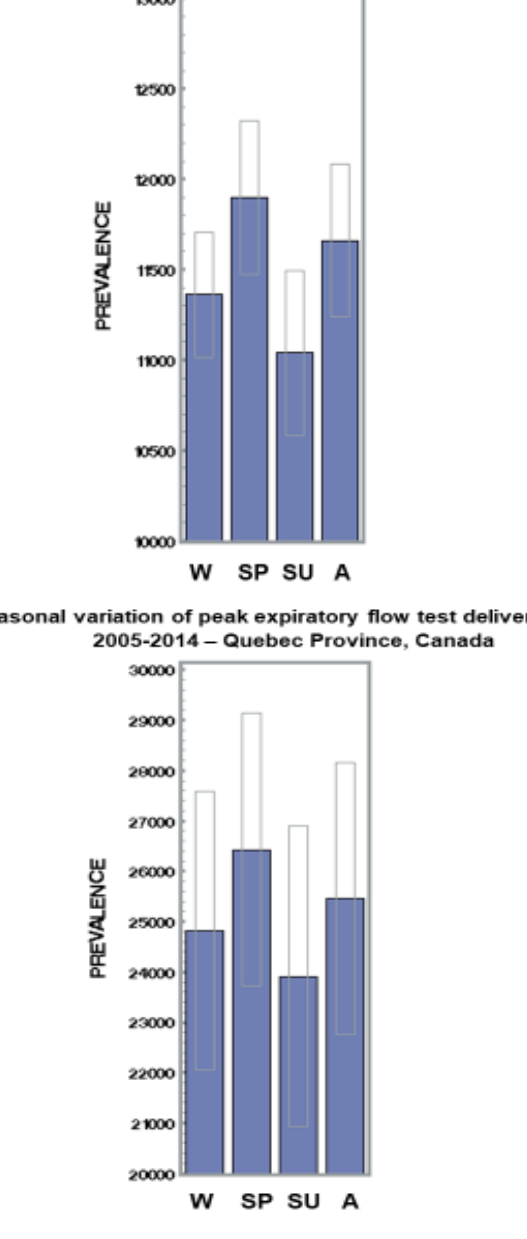
Figure 3. Prevalence of PEFR (peak expiratory flow rate) seasonal variation for: ( A ) Montreal; ( B ) the whole province of Québec (2005–2014). W: Winter; SP: Spring; SU: summer; A: Autumn. Gray bars indicate 95% confidence interval.